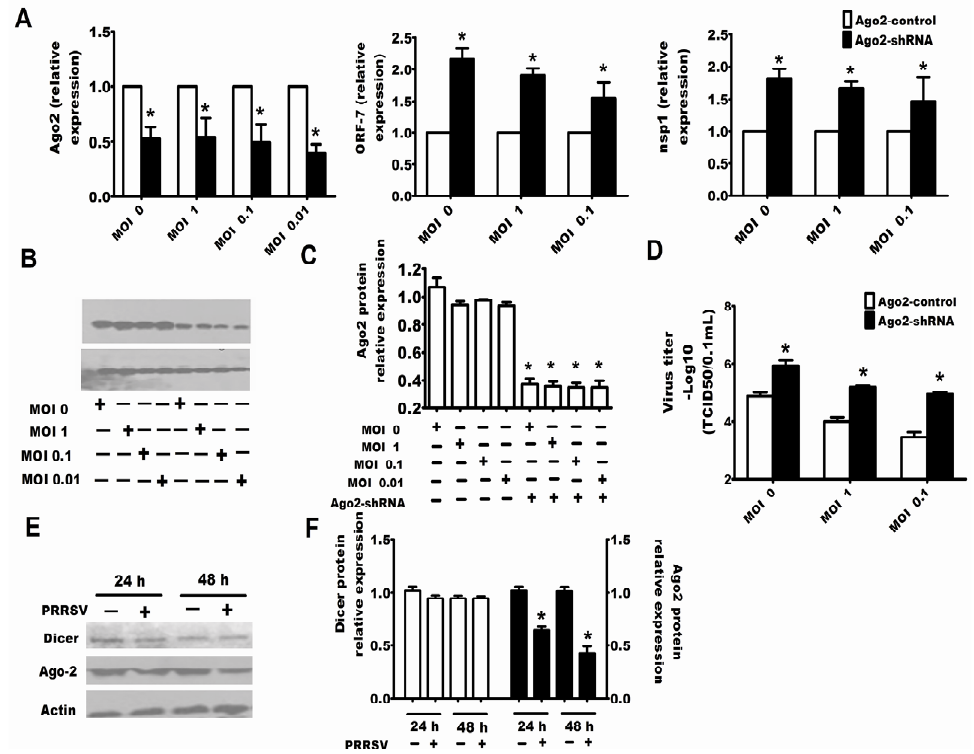
Figure 4. Ago-2 was involved in protection against PRRSV replication, and PRRSV downregulated the Ago-2 expression in MARC-145 cells. Cells of MARC-145 were transfected with Ago-2-shRNA ( A ), and after 24 hours, the cells were infected with PRRSV at an MOI of 1, 0.1 or 0.01. Additionally, 24 h after the infection by PRRSV, cells were collected for qRT-PCR of Ago-2, PRRSV ORF-7 and nsp1 ( A ) or cells were collected for Western blots for Ago-2 ( B ). Western blot results for Ago-2 were quantified by Quantity One Software ( C ); while the viral yields in the supernatants were also quantified by TCID 50 ( D ); ( E ) MARC-145 cells were infected with PRRSV at an MOI of 0.1, and the cells were collected for Western blotting to detect the expression level of Dicer and Ago-2 after 24 and 48 h; and the Western blot results for Dicer and Ago-2 were quantified by Quantity One Software ( F ). The experiments were repeated three times. The results are from one of three independent experiments with similar observations. * p < 0.05.